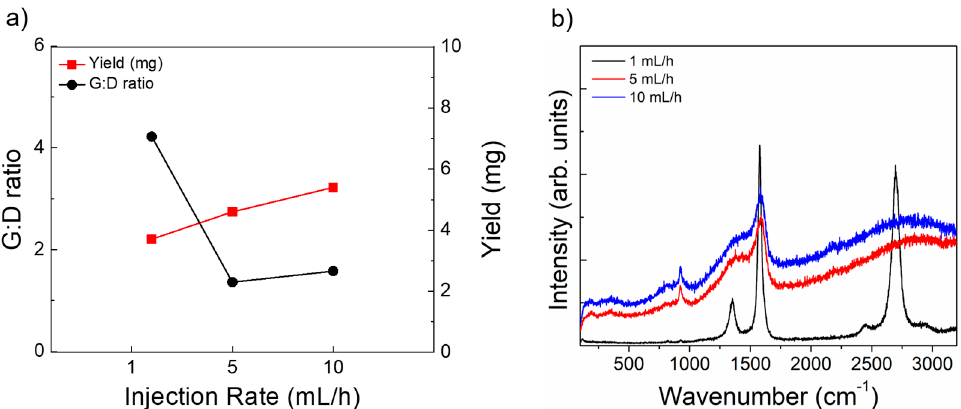
Figure 9. Plot of the Raman G:D ratio (black) and product yield (red) for DLICVD experiments with variable injection rate ( a ) with the corresponding Raman spectra ( b ). Experiments were performed with an aspiration temperature of 225 °C, a reaction temperature of 1000 °C, a 1.25 wt.% catalyst concentration, using EtOH as a carbon source. C 2018 , 4 , 5